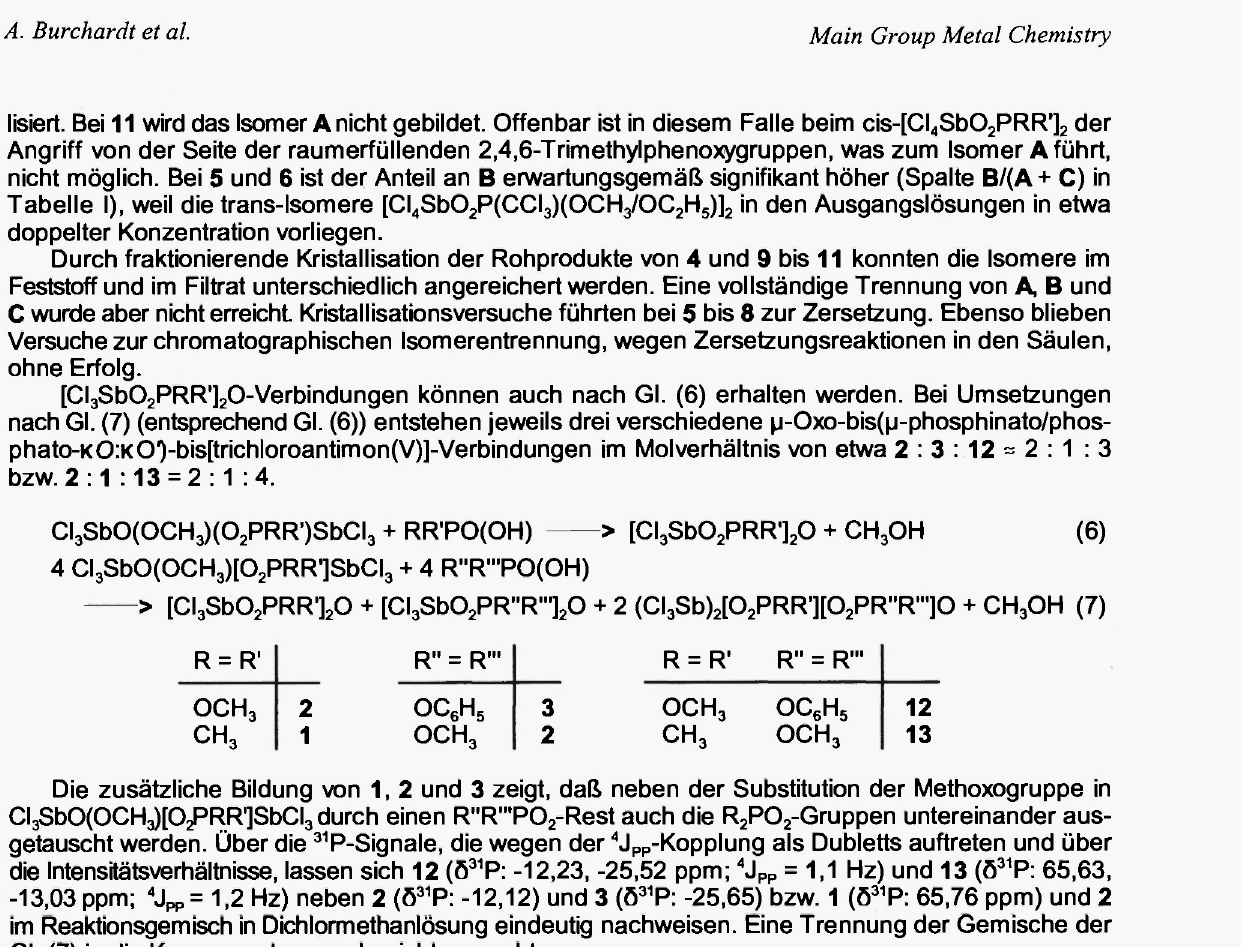
Gl. (7) in die Komponenten wurde nicht versucht. NMR-Spektren